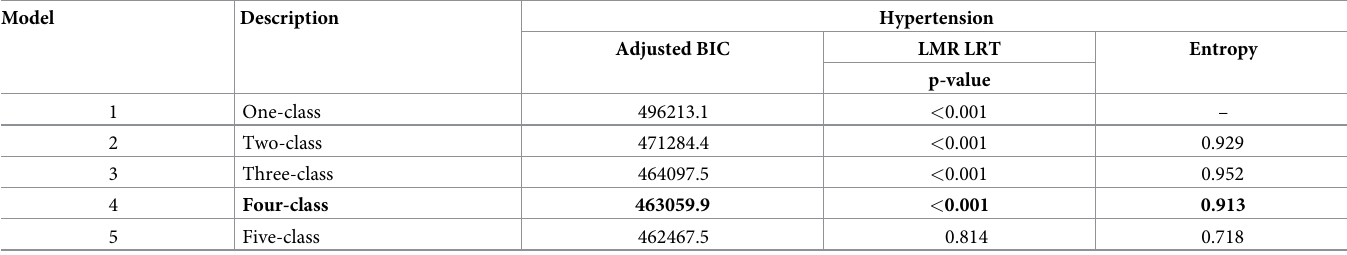
Table 2. Best fitting